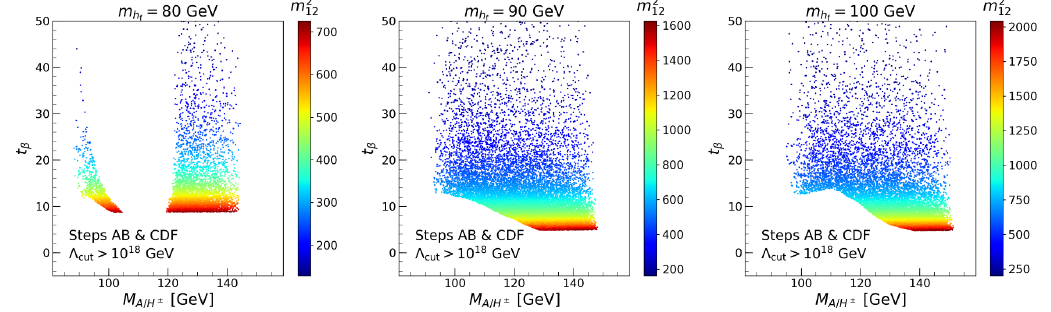
Figure 7 . t β versus M for the parameter points with Λ cut > 10 18 GeV after imposing the CDF A/H ± 4 γX constraint. The color codes denote m 2 in units of GeV 2 . The results for m h 12 are in the left, middle, and right panel,